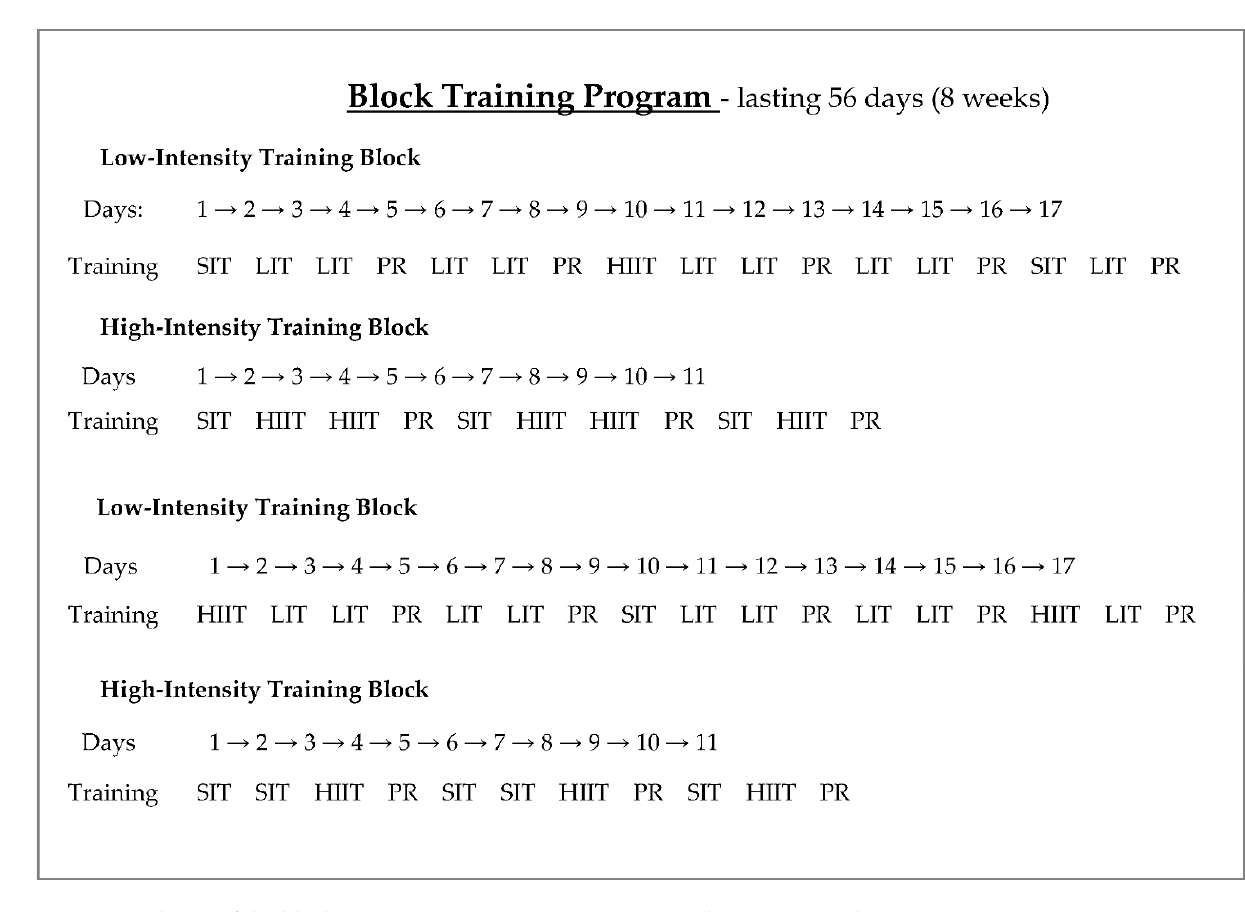
Figure 1. Scheme of the block training program (SIT–sprint interval training; LIT–low-intensity training; PR–passive rest; HIIT–high-intensity interval training).